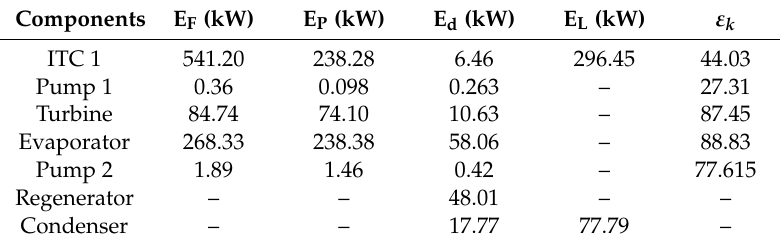
Table 8. Exergy values for each